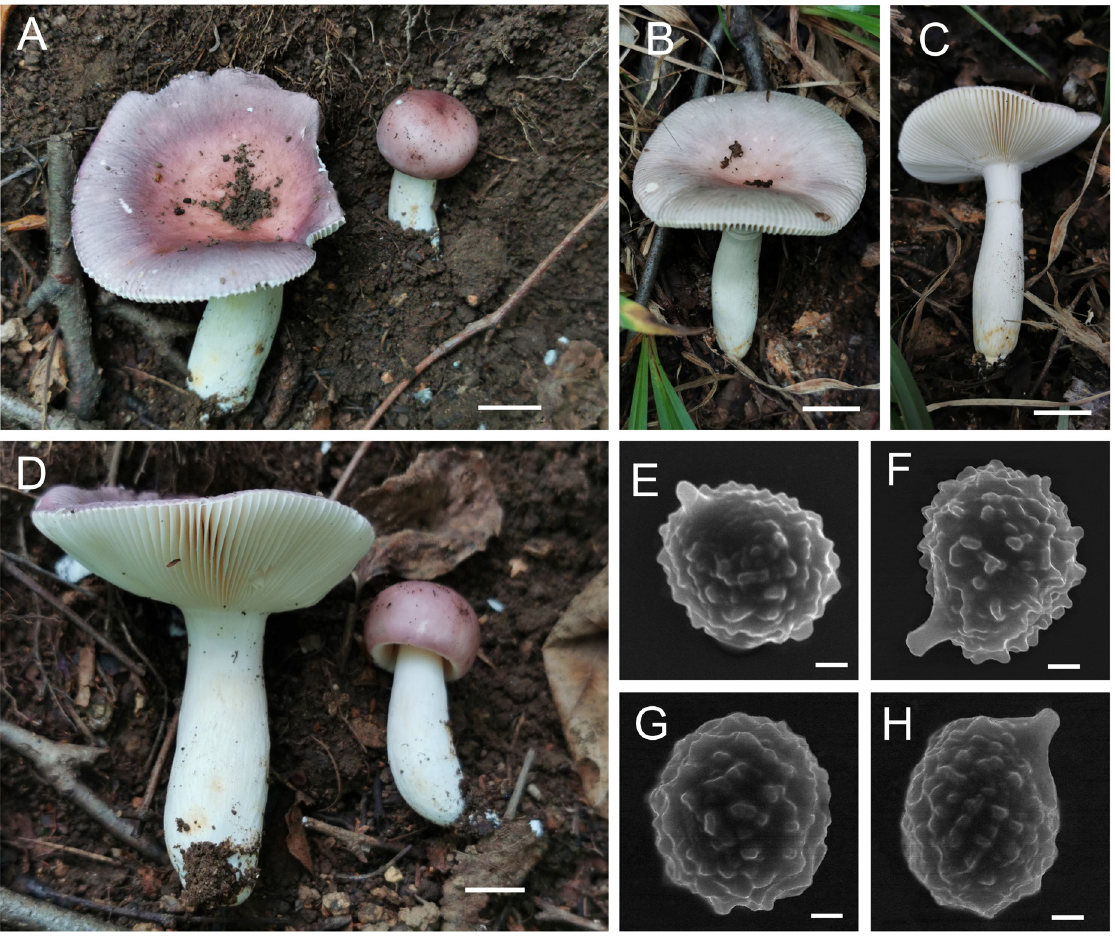
Fig. 5. Basidiomata and basidiospores of Russula wulingshanensis C.L.Hou, G.Q.Cheng & H.Zhou sp. nov. A–D . Basidiomata (A–D = BJTC C403, holotype; B–C = BJTC C399). E–H . SEM micrograph of basidiospores (BJTC C403, holotype). Scale bars: A–D = 10 mm, E–H = 1